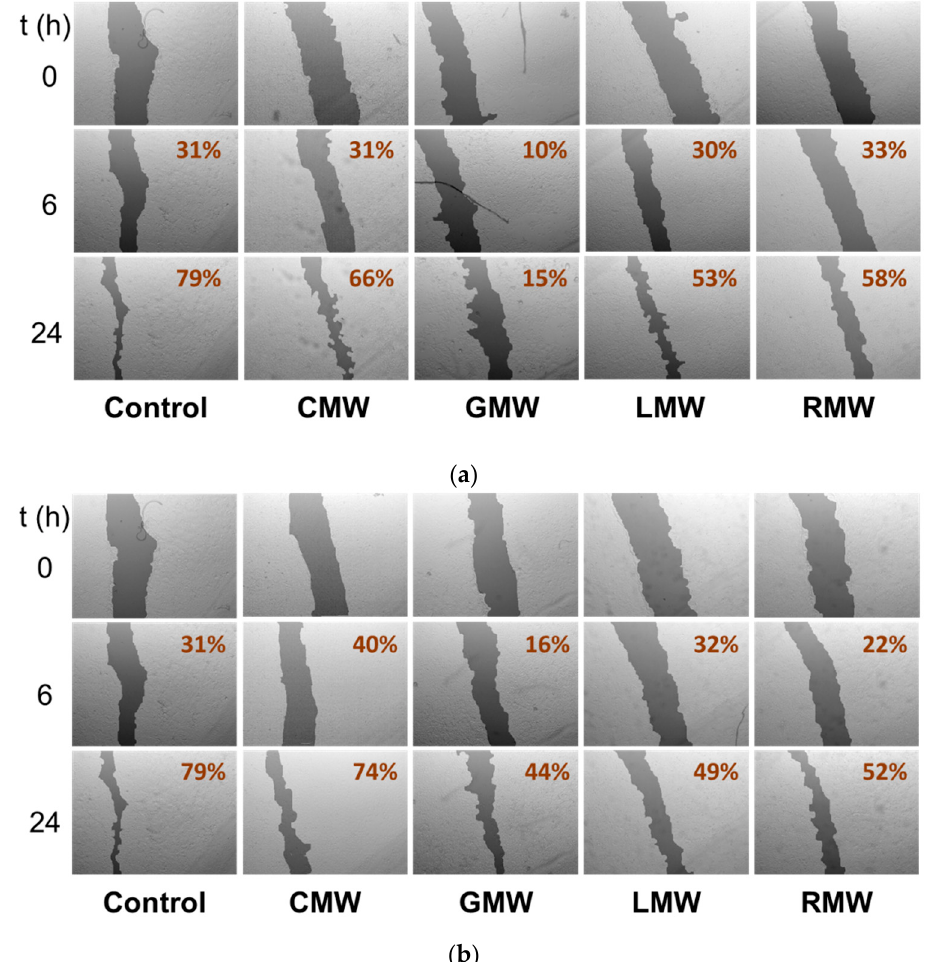
Figure 4. Wound closure assay results on A549 cells when using 100 µg/mL ( a ) and 50 µg/mL ( b ) of MW microextracts. Wound closure percentage with respect to time = 0 is given on the right top corner of each image.